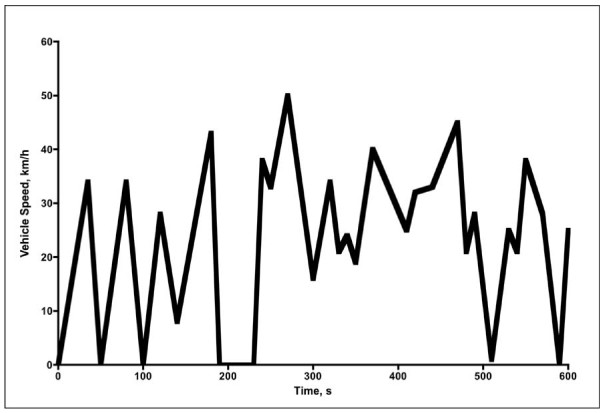
The urban sequence of the European Transient Cycle applied in the present study.